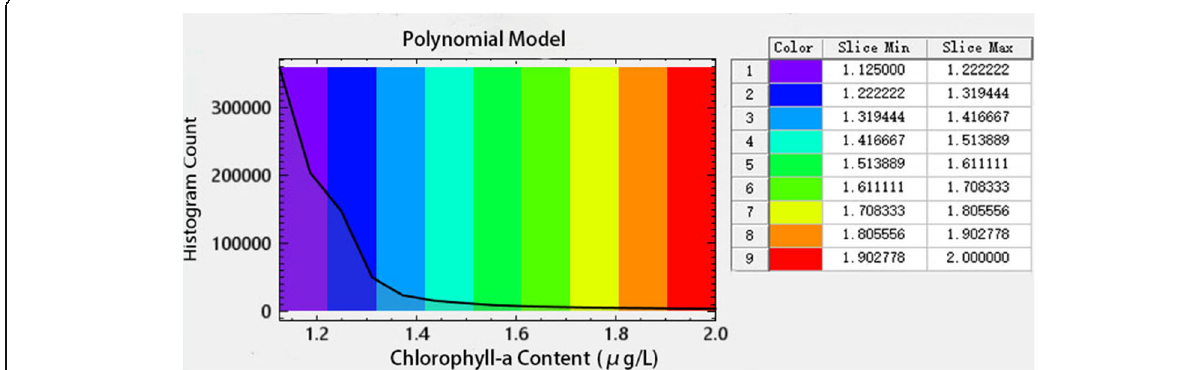
Fig. 14 Chl-a value and wind speed value of